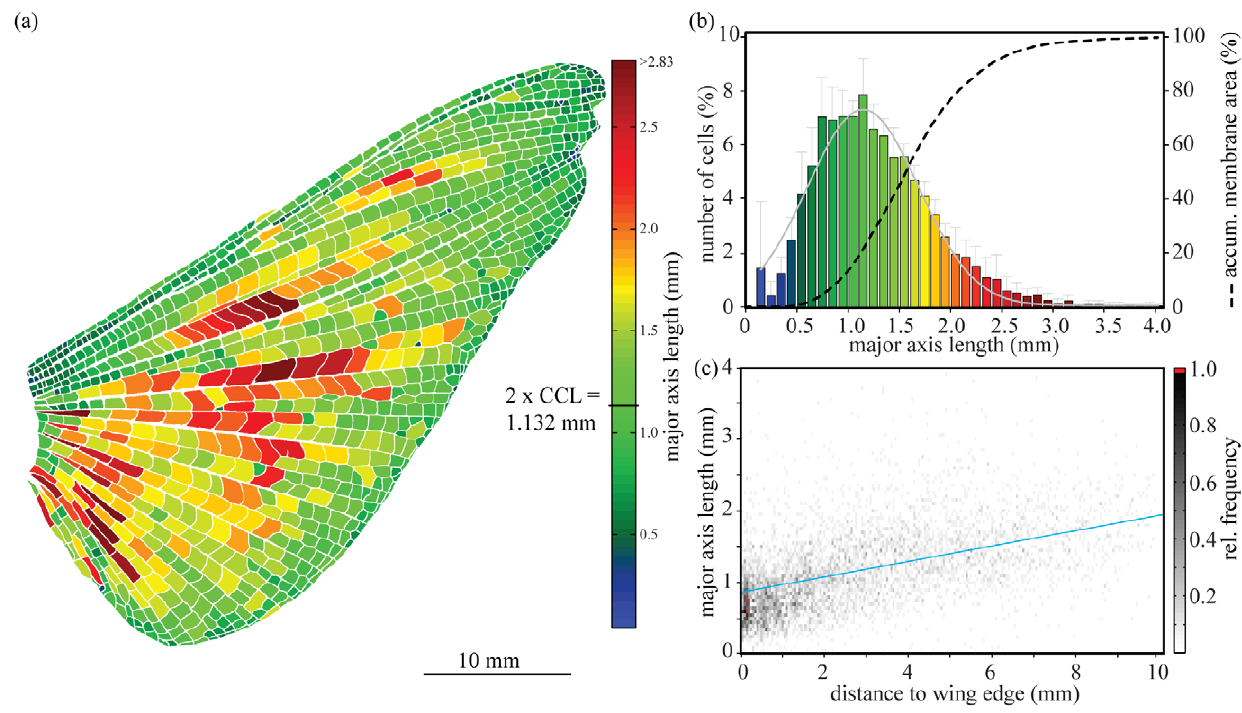
Figure 3. Size and distribution of wing cells in S.gregaria hind wings. (a) Typical structure of a hind wing, showing the distribution of the wing cells’ major axis length. Cells with smaller major axis lengths are mostly arranged around the perimeter of the wing (CCL: critical crack length). (b) Mean frequency of wing cell sizes from six hind wings. The distribution of cells corresponds very well to a normal distribution around a mean major axis length of 1.103 mm ( s =544.16, a=7.33, R=0.98). The cumulative membrane area formed by cells smaller than the critical crack length is 19.44% of the overall membrane area (mean 6 SD, N=5553 cells from 6 wings). The colour map of the bars corresponds to subfigure A. (c) 2D- Histogram showing the relative frequency of cell size and their distance to the wing edge. There is a significant positive correlation of the major axis length with the distance to the wing edge ( r =0.393, R 2 =0.154, p , 0.001, linear correlation, N=5553 cells).